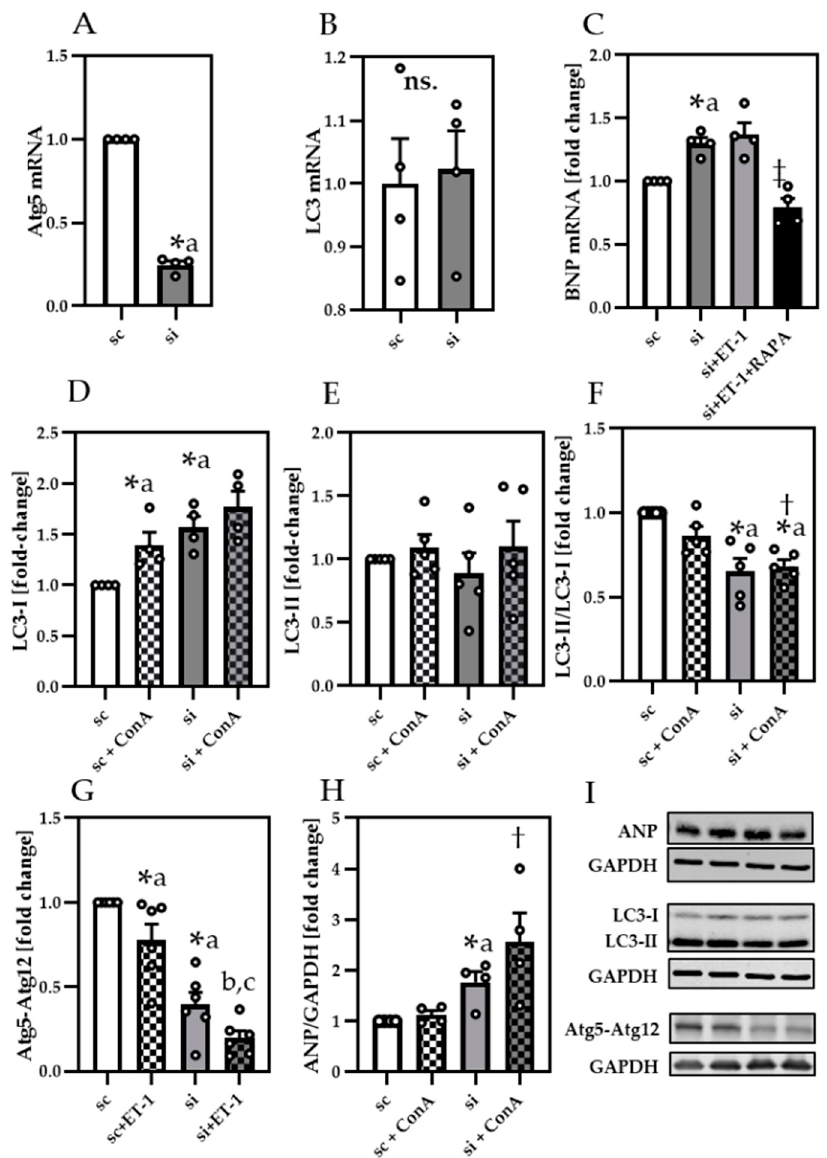
Figure 5. Atg5 silencing increased ANP and decreased LC3-II lipidation ( A ) Relative gene expression of Atg5, ( B ) LC3 and ( C ) BNP. Protein analysis of ( D ) LC3-I, ( E ) LC3-II, ( F ) LC3-II/GAPDH to LC3-I/GAPDH ( G ) Atg5-Atg12 conjugate and ( H ) atrial natriuretic peptide (ANP) in scramble control (sc) and siAtg5 (si) treated neonatal cardiomyocytes. ( I ) Representative immunoblots of ANP, LC3-I, LC3-II, Atg5-Atg12 conjugate and their respective GAPDH control. Data are presented as fold change of sc and shown as Mean + SEM of biological replicates. Statistical analyses were performed by unpaired t-test or one-sample t-test (indicated with a), comparing two treatments directly. Statistically significant differences were shown by p < 0.05, * vs. sc, ‡ vs. si + ET-1, † vs. sc + ConA, b vs. sc + ET-1 and c vs. si. ns = not significant. In line with our results from pressure overload mice and ET-1 treated cardiomyo- cytes, Atg5-silenced (si) cells exhibited a prominent increase of BNP mRNA (Figure 5C),